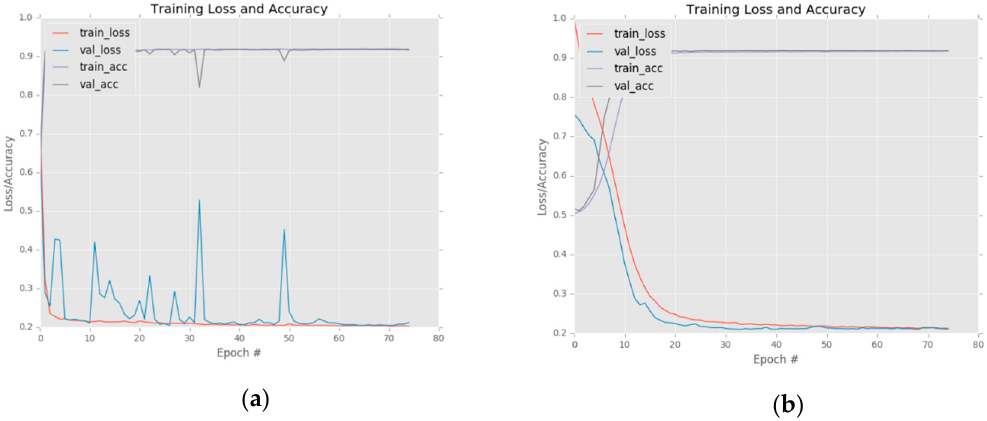
Figure 4. The impact of learning rate on performance during training with ( a ) a 0.001 initial learning rate, and ( b ) a 0.0001 initial learning rate.